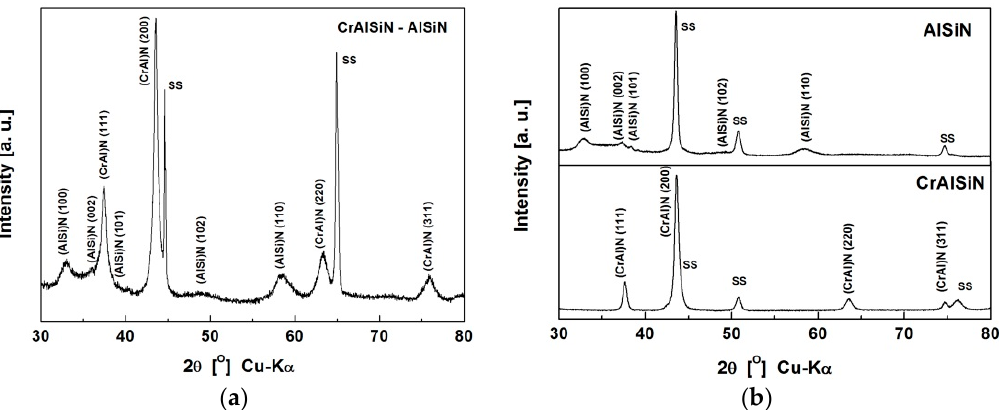
Figure 8. XRD pattern of the ( a ) modulated CrAlSiN–AlSiN coating and ( b ) reference CrAlSiN and AlSiN coatings. AlSiN